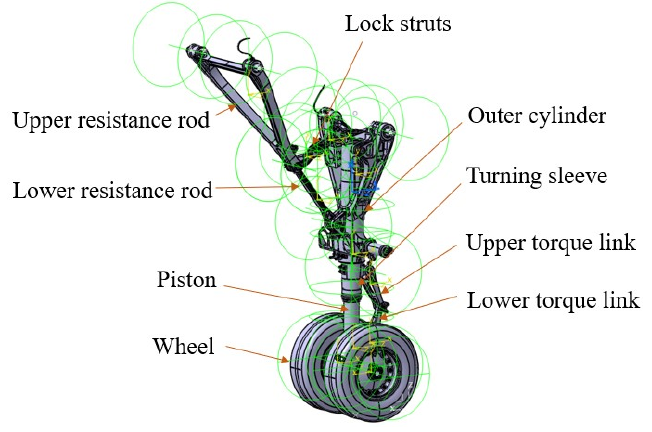
Figure 2. MBD model of the NLG.